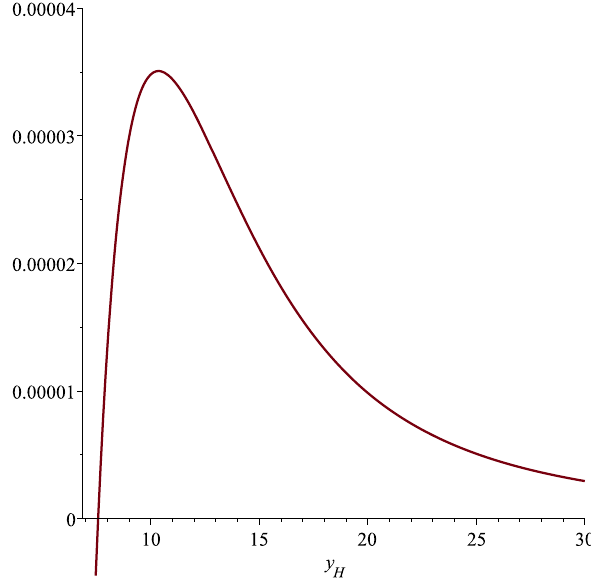
Fig. 4 Plot of T H versus y H = ( r H / h ) 1 /ξ in h units for ξ = 3. We have T H = 0 for y H = y 0 = 7 . 57496, which coincides with the event horizon of the corresponding extremal black hole. The maximum temperature is T H , max = 3 . 5 × 10 − 5 and it corresponds to a mass parameter μ = 787 .